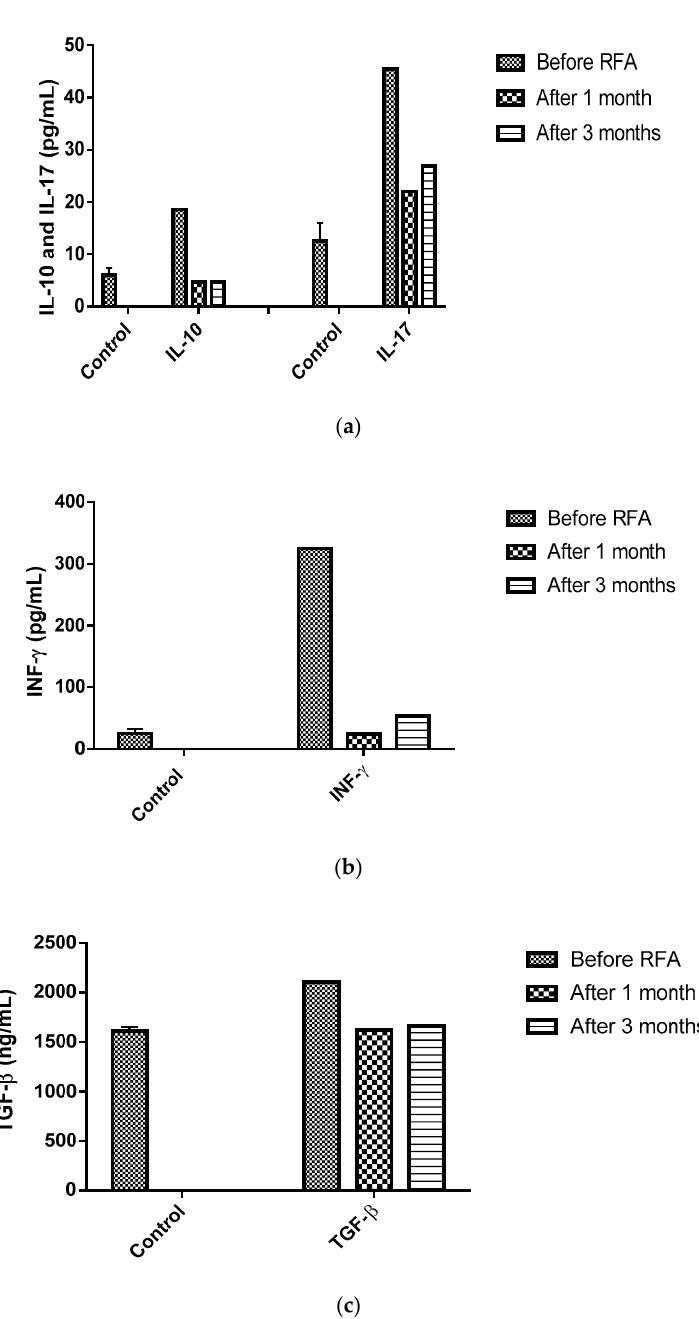
Figure 7. Altered levels of serum cytokines in the patient with colorectal liver metastasis before the RFA procedure and one and three months after the procedure. The concentrations of ( a ) IL-10 (upper panel) and ( b ) INF- γ (lower panel) decreased after one month and were not modified three months after the RFA procedure. The concentration of IL-17 (a) decreased after one month and slightly increased after three months. ( c ) The concentration of TGF- β decreased after one month and was not modified three months after the RFA procedure.